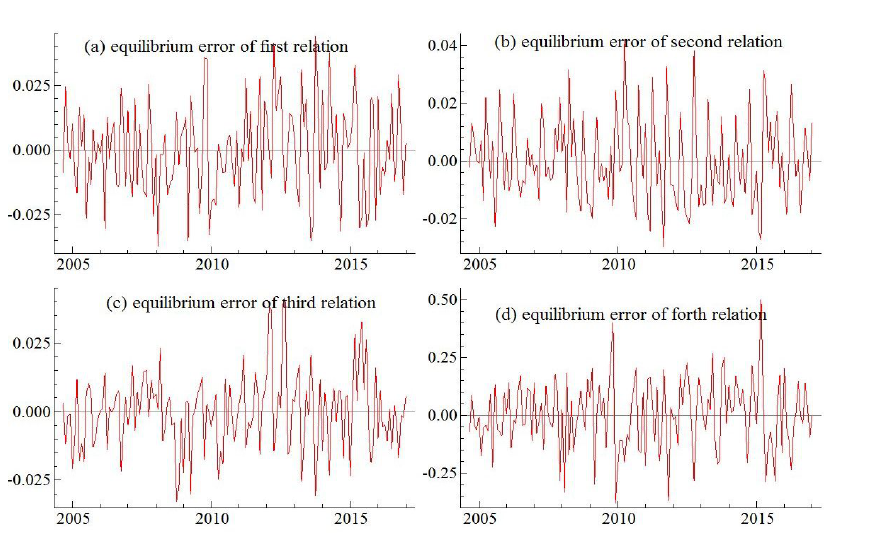
Figure 7: Graphs of the estimated cointegration relations. Panel (a) shows the equilibrium errors of the Phillips curve relation, panel (b) of the bond rate - unemployment rate crisis relationship, panel (c) of the Phelpsian natural rate relation, and panel (d) the confidence rate